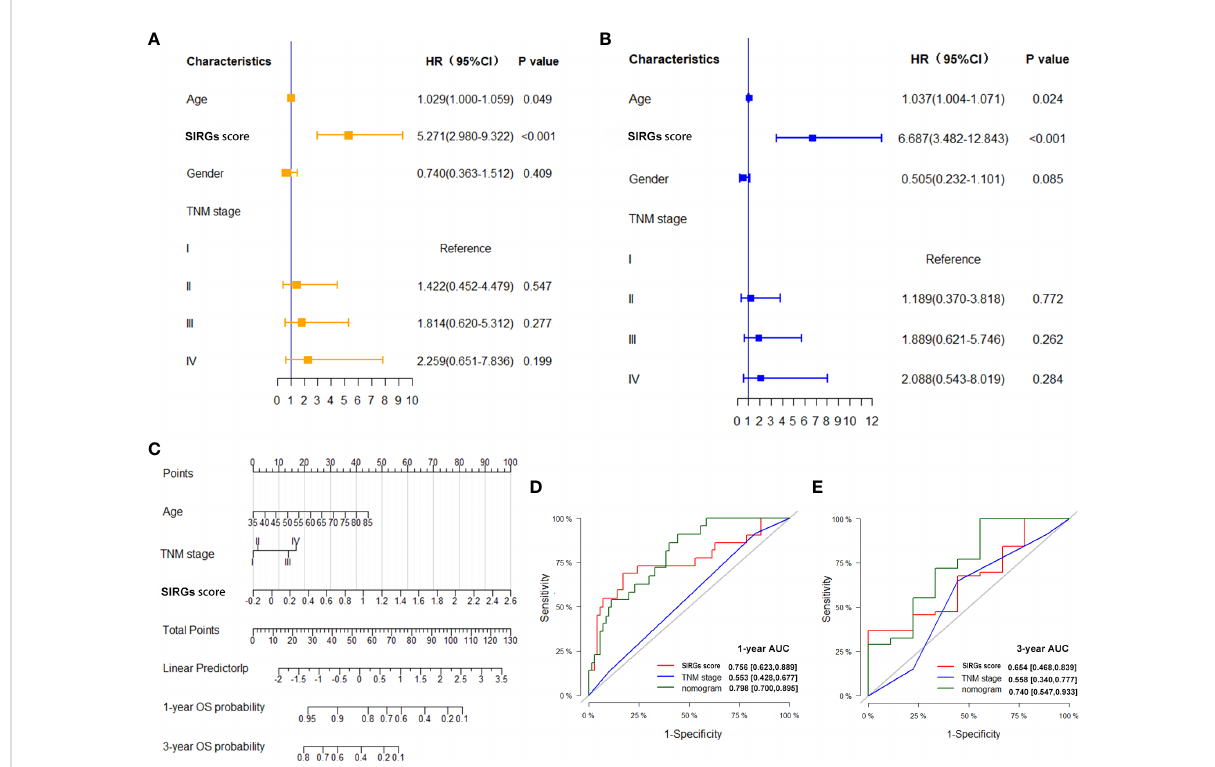
FIGURE 4 Establishment SIRGs score-based nomogram for predicting EGJA patients ’ prognosis. (A) Forest plot presenting univariate Cox regression analysis result; (B) Forest plot presenting multivariate Cox regression analysis result; (C) SIRGs score-based nomogram; (D) AUC values of ROC